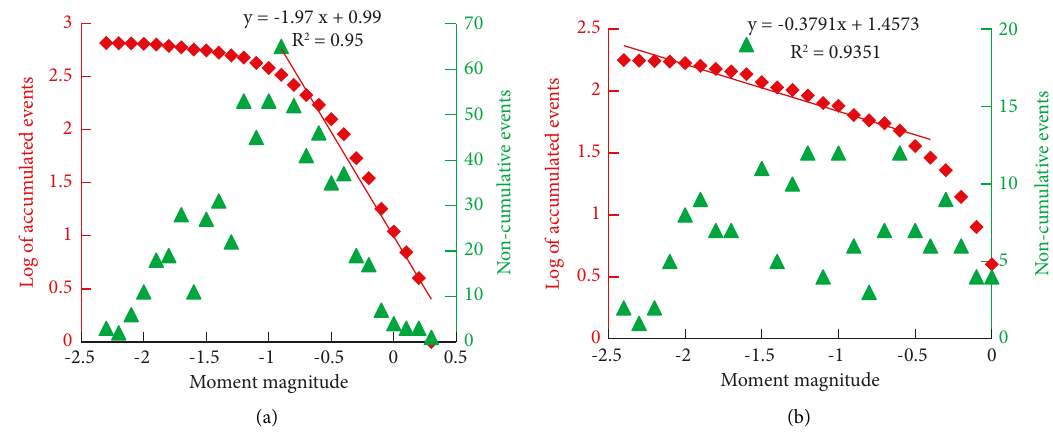
Figure 20: Moment magnitude-frequency curve of the main powerhouse. (a) In 2018. (b) In curve of microseismic events in main powerhouse in Fig- ure 20 are drawn. Combined with the time relationship